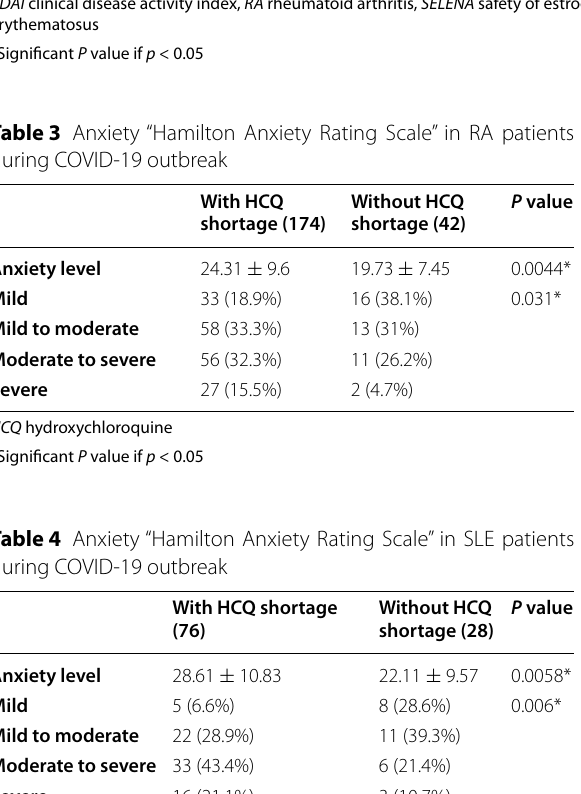
SLE systemic lupus erythematosus, HCQ hydroxychloroquine